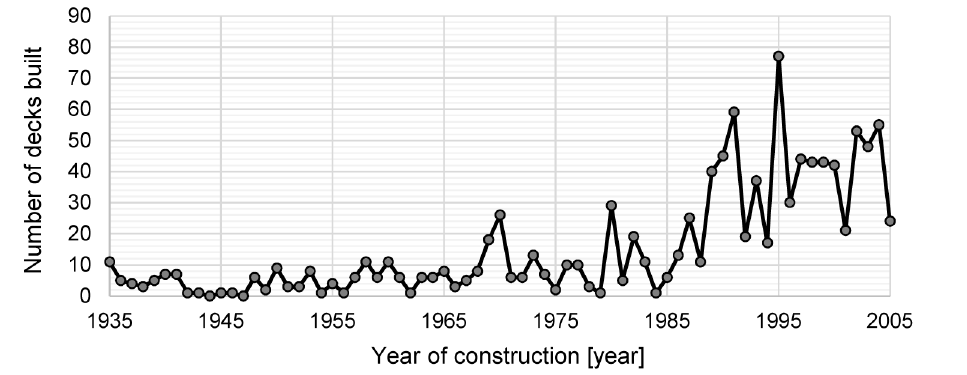
Fig. 1. Years of construction of decks used as the input for some of the models